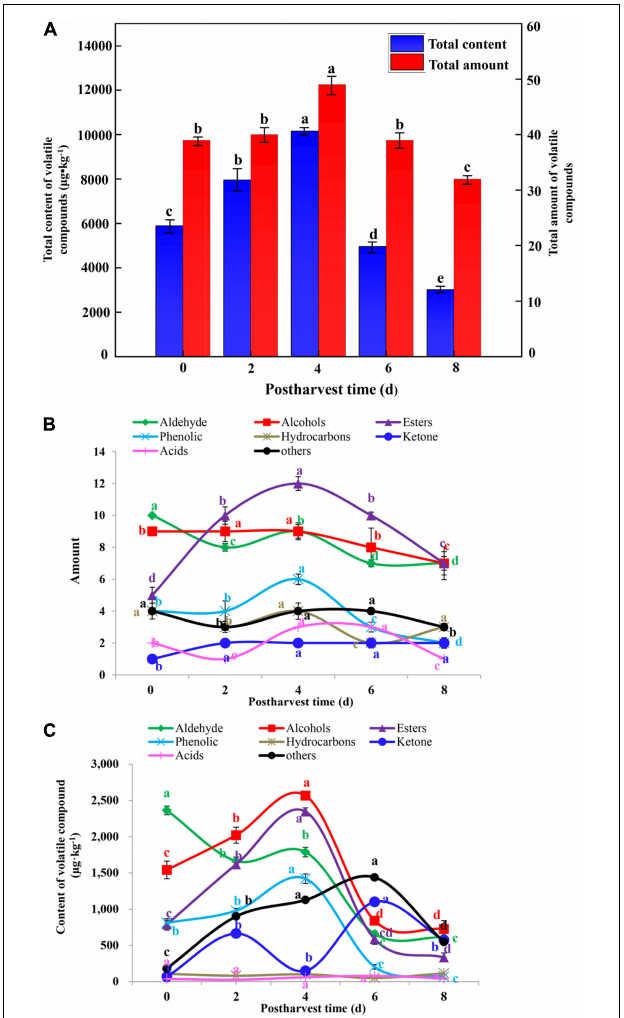
FIGURE 5 | Analysis of the total content and amount (A) of volatile compounds of cut lily flowers and the amount (B) and content (C) of various category volatile compounds of cut lily flowers and during the postharvest process. Different lowercase letters in the figure indicate significant differences at the level of P < 0.05